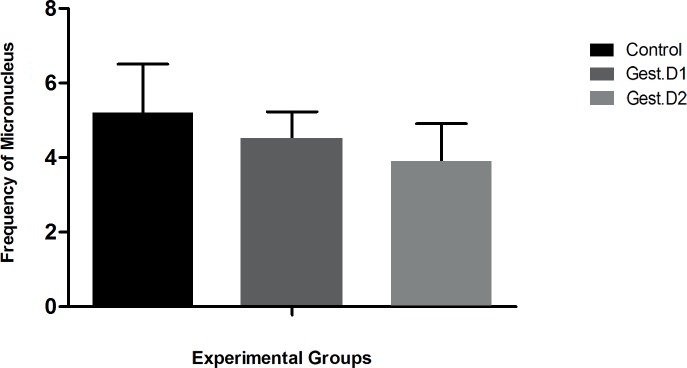
Micronucleus frequency after treatment.(Test: analysis of variance/Tukey, p<0.05).